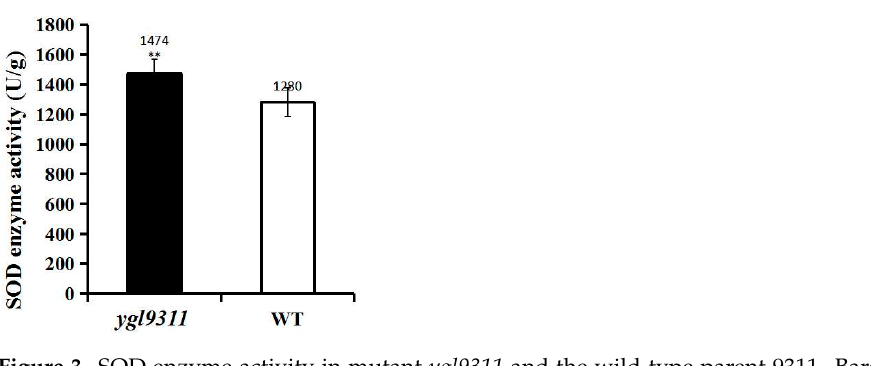
Figure 3. SOD enzyme activity in mutant ygl9311 and the wild-type parent 9311. Bars represent standard deviations of three independent measurements. Significant differences were determined by Duncan ′ s Multiple Range test.